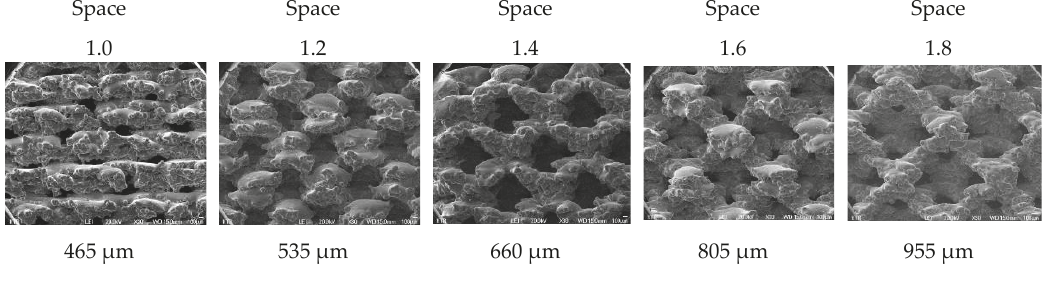
Figure 6. SEM measurement result by porous size.